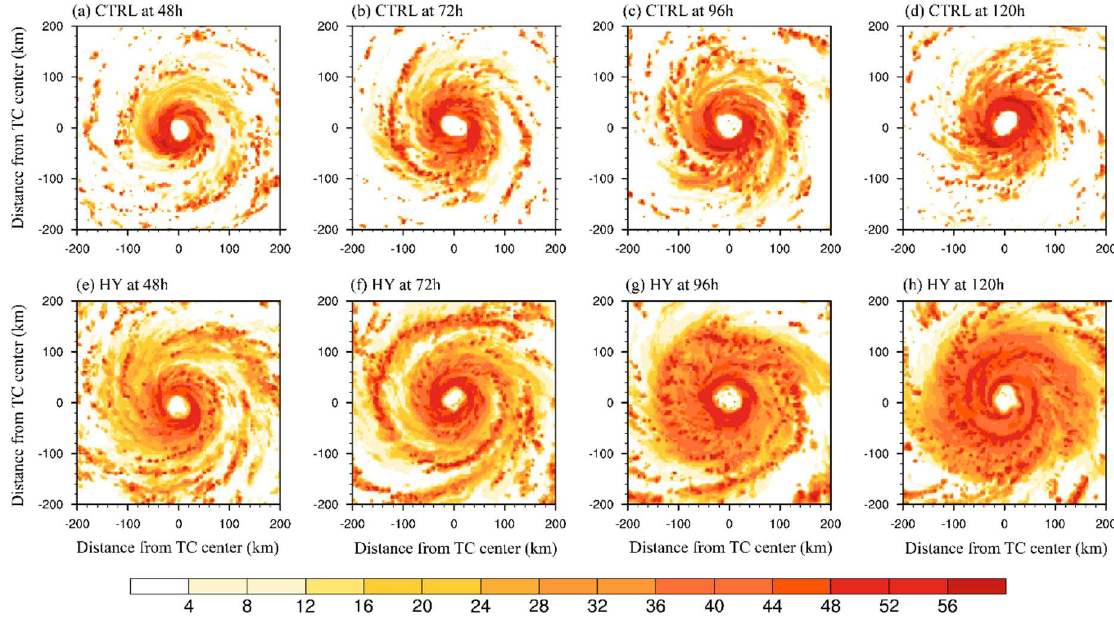
Figure 4. Plan views of the simulated maximum radar reflectivity (dBZ) between 24 and 96 h at intervals of 24 h for ( a, b, c, d ) CTRL and ( e, f, g, h ) HY, showing the evolutionary trend of rainbands.